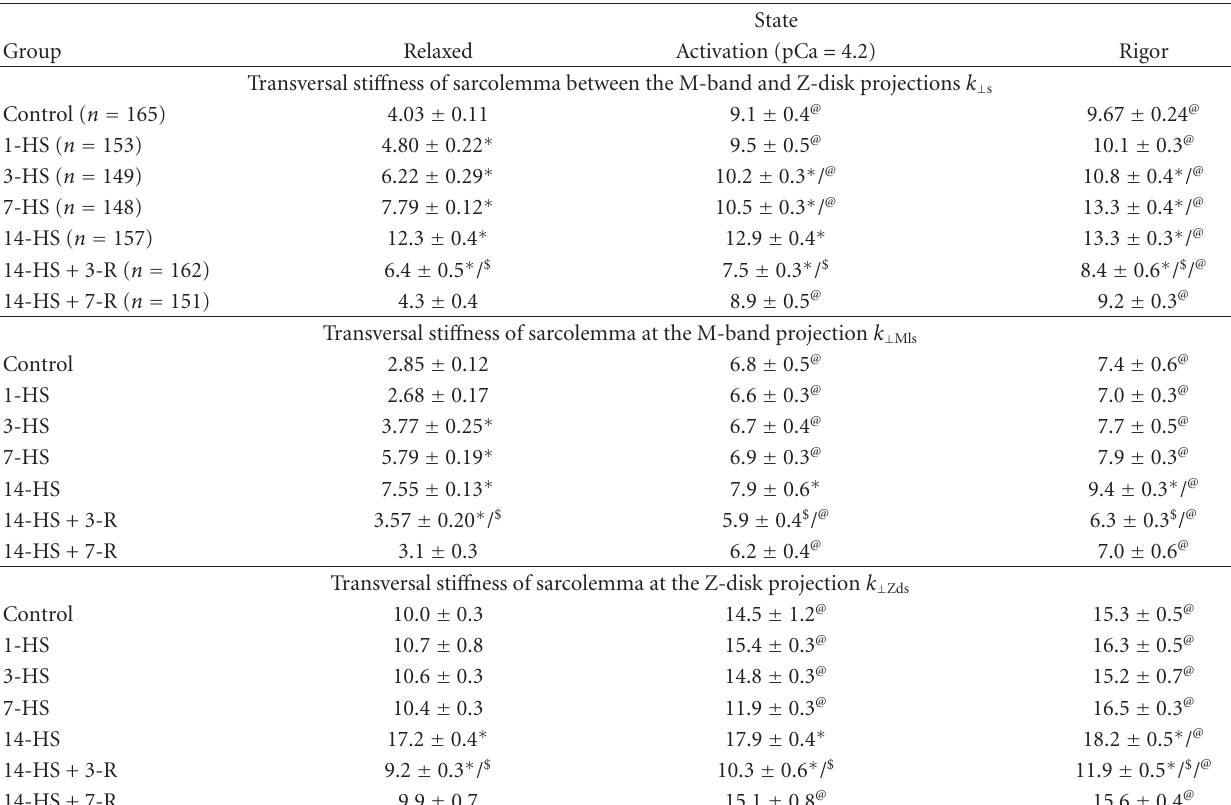
Table 2: Transversal sti ff ness (pN/nm) of isolated rat’s permeabilized left ventricular myocytes in liquid in relaxed, calcium activated (pCa = 4.2) and rigor states under gravitational unloading and subsequent reloading.